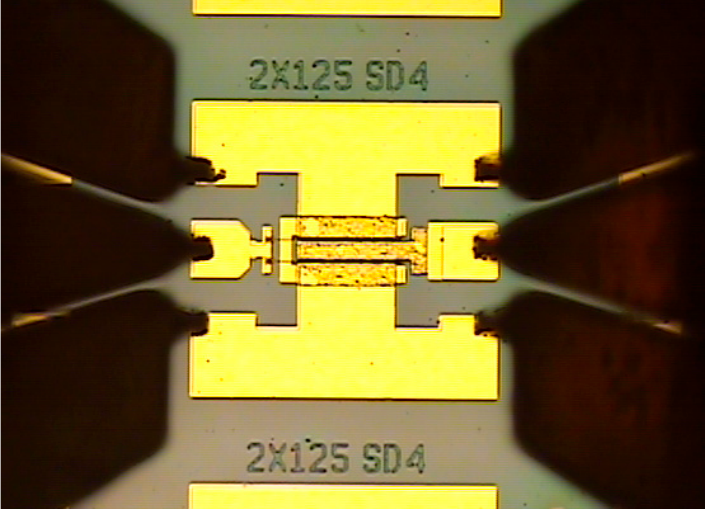
Figure 3. Optical images of NDC-GaN HEMTs when electrical properties are tested.